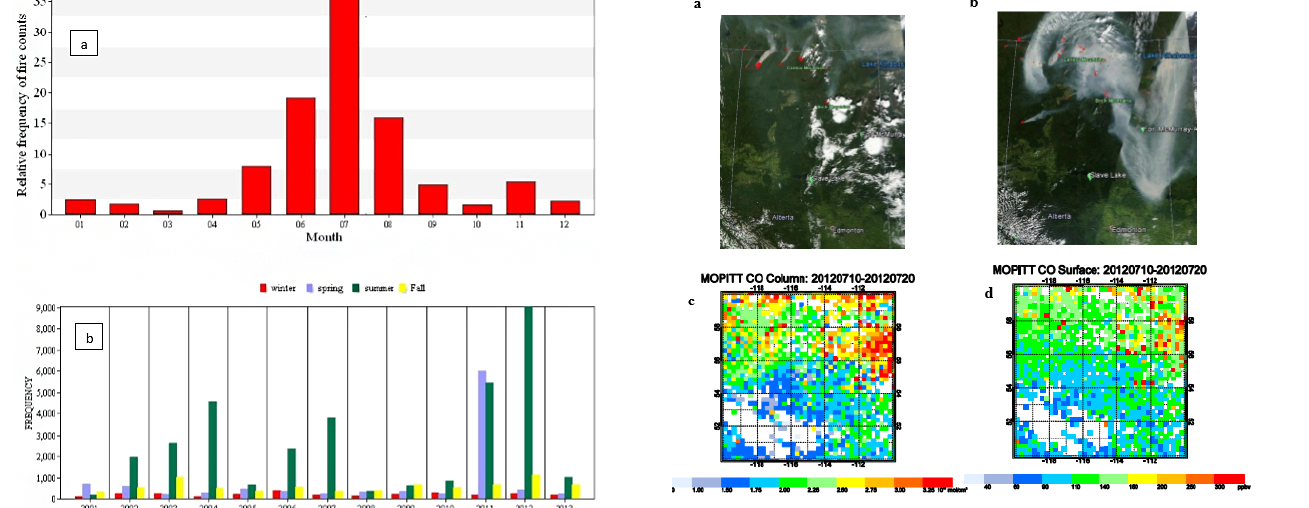
Figure 12. (a) Monthly variations in MODIS fire counts for the study period (2001–2013) over Alberta. (b) Interannual variations in seasonal fire frequency.